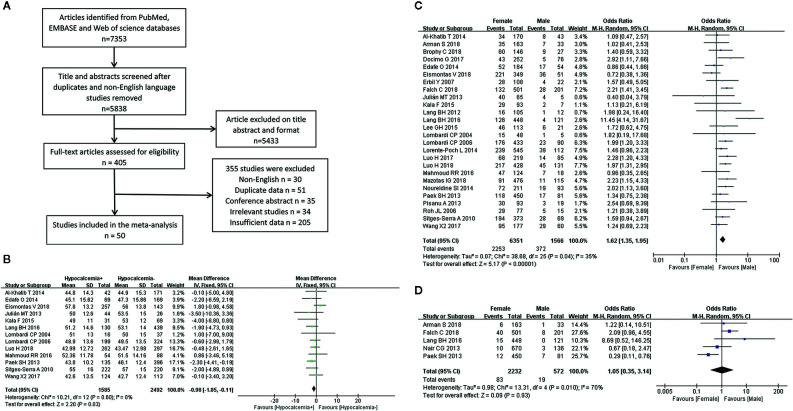
Flowchart of the meta-analysis (A) and the meta-analysis results for the incidence of hypocalcemia shown between the two groups; (B) Age for transient hypocalcemia; (C) Gender for transient hypocalcemia; (D) Gender for permanent hypocalcemia.